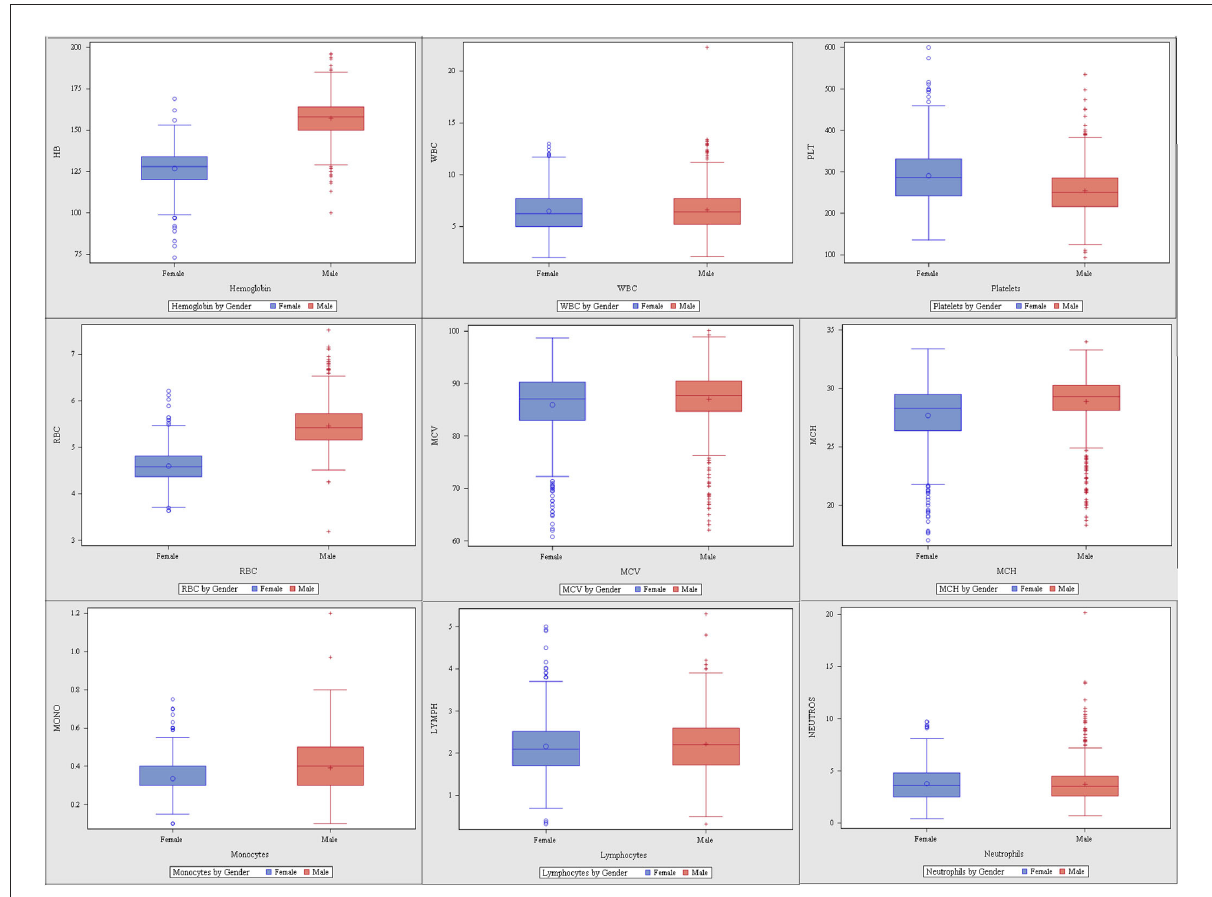
FIGURE1 Complete blood count (CBC) parameters ranges of the study cohort by